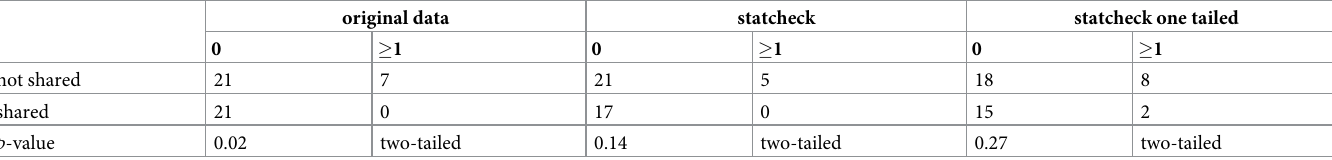
Table 9. Presence decision errors and data